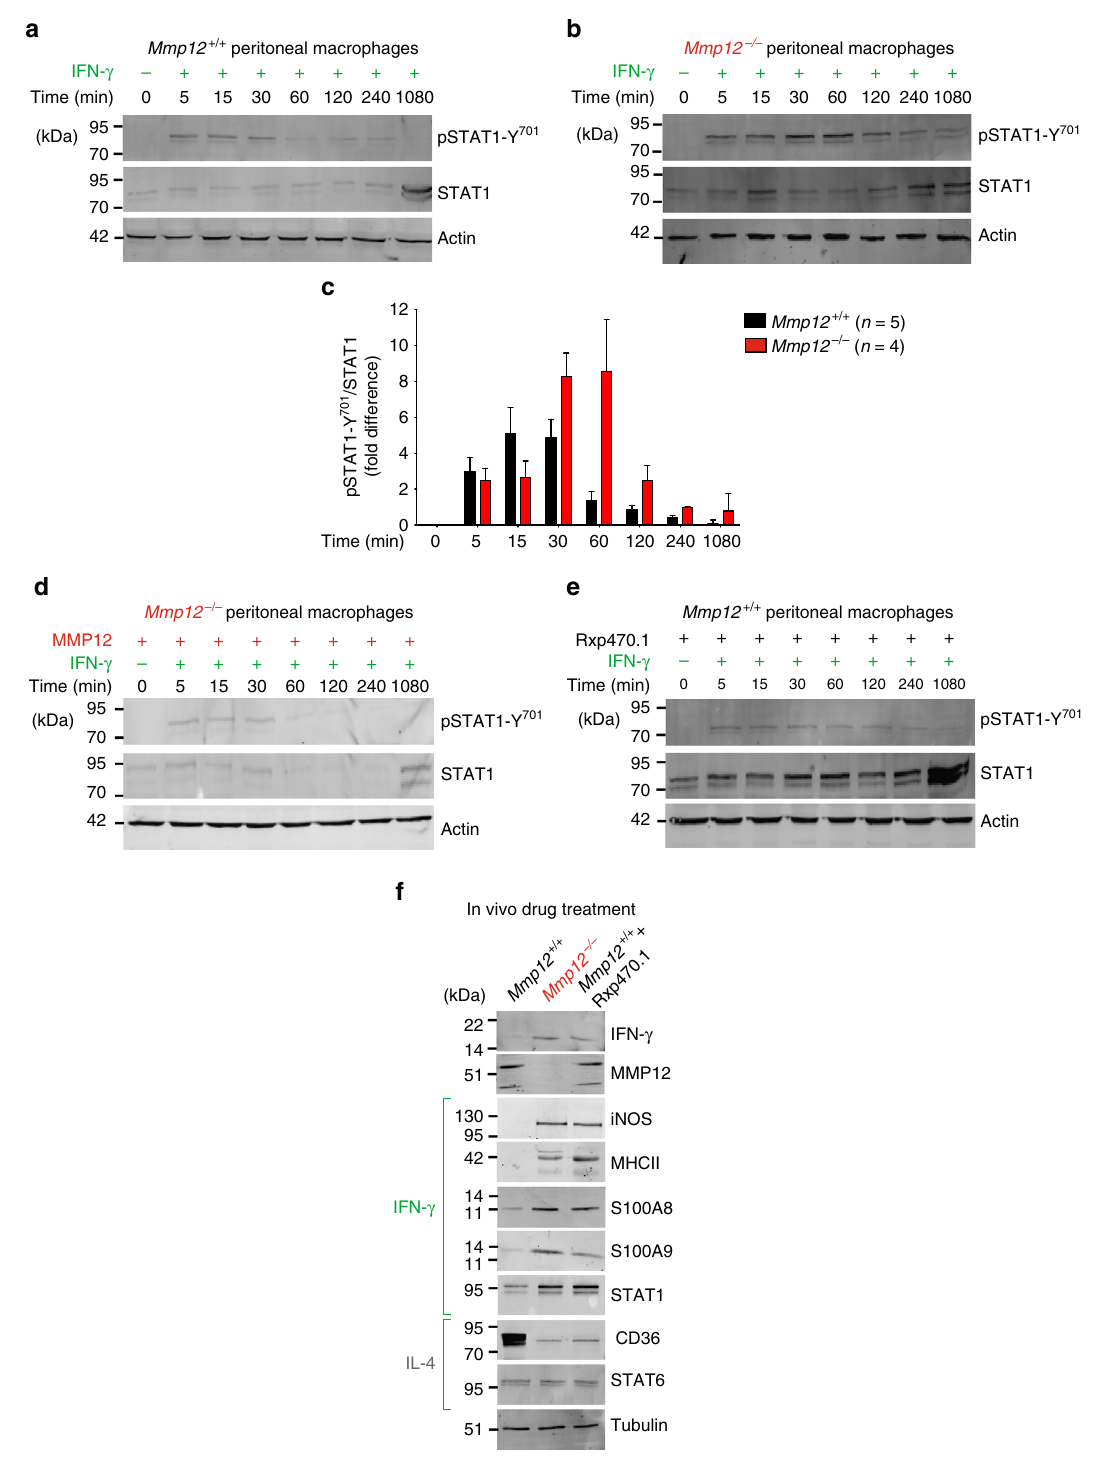
Fig. 8 Prolonged IFN- γ signaling in Mmp12 – / – primary peritoneal macrophages. Western blot analysis for pSTAT1-Y701 and STAT1 in primary peritoneal macrophages harvested from individual ( a , e ) Mmp12 + / + B10.RIII ( n = 5 for each time point) and ( b , d ) Mmp12 – / – B10.RIII ( n = 4 for each time point) mice 4 days after induction of peritonitis. Cells were treated with 20 ng/mL of IFN- γ for 0 – 1080 min. c Ratios of pSTAT1-Y701 to STAT1 protein levels were determined after densitometry quanti fi cation of the western blots. The data are expressed as fold differences in the ratio of the means for Mmp12 + / + ( n = 5 for each time point) and Mmp12 – / – ( n = 4 for each time point) B10.RIII mice. d Rescue of Mmp12 – / – peritoneal macrophages with recombinant mouse MMP12 protein (1:100) incubated for the times shown ( n = 4 for each time point). e Mmp12 + / + B10.RIII macrophages were incubated for 30 min with 100 nm speci fi c MMP12 inhibitor Rxp470.1 before addition of 20 ng/mL IFN- γ ( n = 4 for each time point). f Western blot analysis of IFN- γ , MMP12, iNOS, MHCII, S100A8, S100A9, STAT1, CD36, and STAT6 proteins in primary peritoneal macrophages harvested from Mmp12 + / + ( n = 4) and Mmp12 – / – ( n = 4) B10.RIII mice at day 4 post-intraperitoneal injection with vehicle; and Mmp12 + / + B10.RIII mice treated daily with 5 mg/kg Rxp470.1 ( n = 4) for 4 days during the induction of peritonitis. Actin or tubulin loading controls and molecular weight marker positions in all blots are as